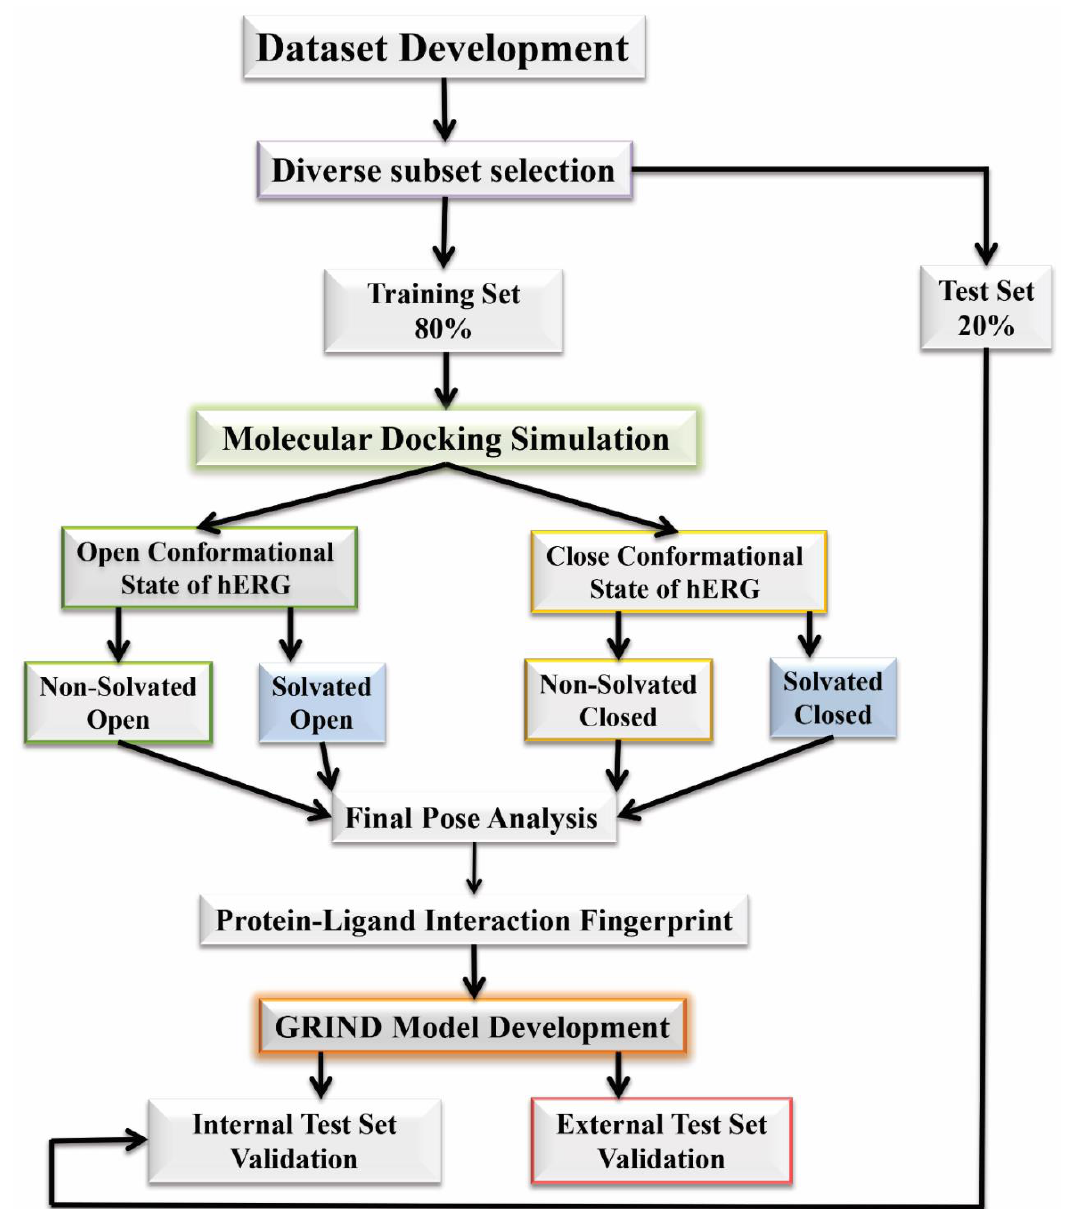
Figure 13. The overall workflow to study the role of explicit water molecules in drug binding of hERG channel and impact of conformational change on the predictive ability of GRIND model .